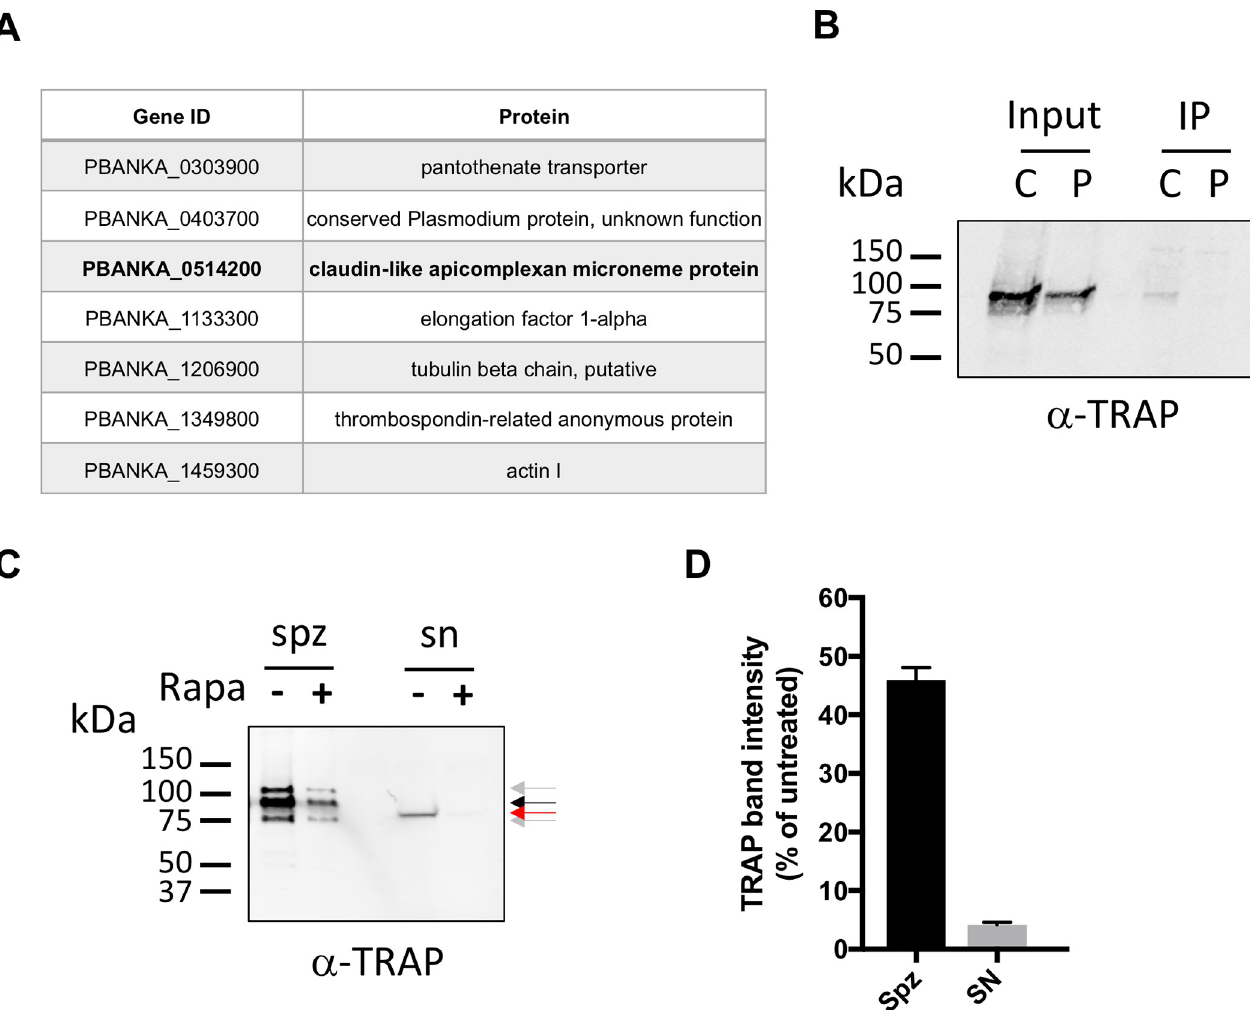
Fig 5. CLAMP is essential for TRAP shedding. A. P . berghei proteins identified by mass spectrometry after anti-Flag immunoprecipitation from two independent CLAMP-flag sporozoite lysates, and not from control samples. B. Additional lysates were prepared from CLAMP-flag and parental P . berghei salivary gland sporozoites, and used for anti-Flag IP followed by western blotting using anti-TRAP antibodies. TRAP was detected in total extracts (input) from both CLAMP-flag (C) and parental (P) samples, but only in CLAMP-Flag immunoprecipitate (IP). C. TRAP secretion assay using haemolymph sporozoites (5 x 10 4 or equivalent per lane) from untreated or rapamycin-treated clamp cKO parasites. Microneme secretion was stimulated by incubation for 15 min at 37˚C in the presence of BSA and ethanol. After stimulation of microneme secretion, samples were fractionated by centrifugation in sporozoite pellets (spz) and supernatants containing secreted proteins (SN), and analyzed by western blot using anti-TRAP antibodies. TRAP protein was detected as a ~100 kDa major band (black arrow) and two minor bands (grey arrows) in sporozoite lysates, and as a single ~75 kDa in supernatants (red arrow). D . Quantification of signal intensity of TRAP western blot bands in sporozoite pellets (main band only) and supernatants. The data show TRAP levels in rapamycin-treated parasites relative to untreated parasites, both in pellets and supernatants.